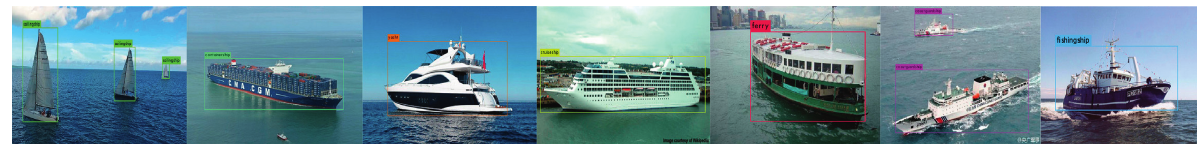
Figure 4: The representative detection results of the improved RDCNN network method.